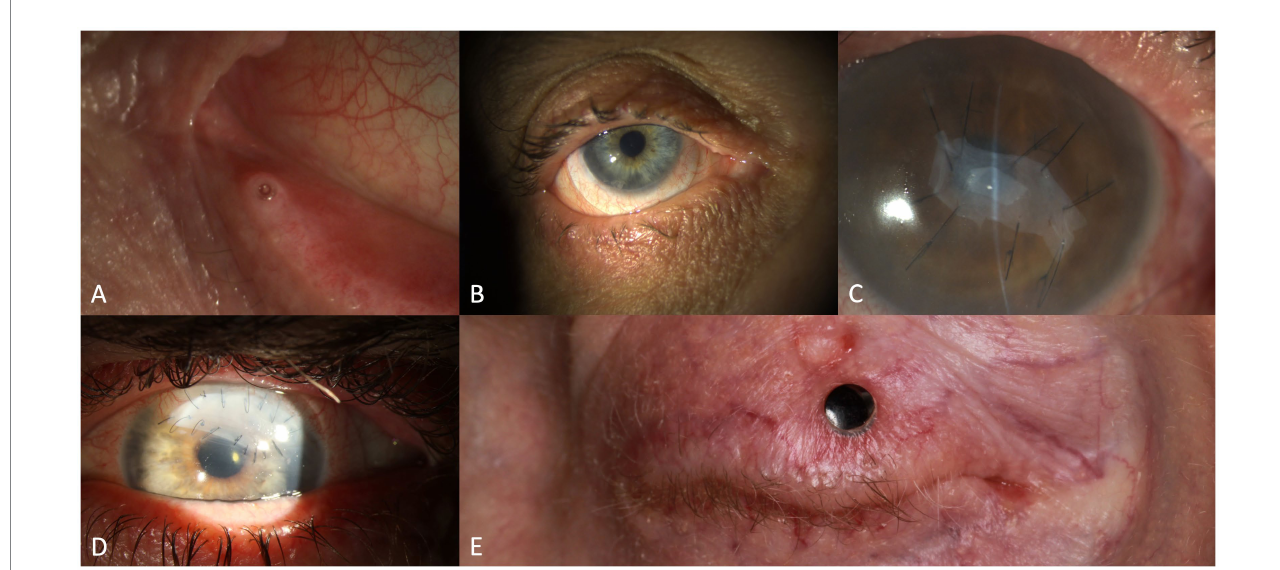
FIGURE 5 Therapeutic interventions in eyes with oGVHD: silicone punctal plug (A) , scleral lens (B) , amniotic membrane transplantation (C) , lamellar keratoplasty with loosening of the sutures (D) , transpalpebral osteo-odonto-keratoprosthesis (E)